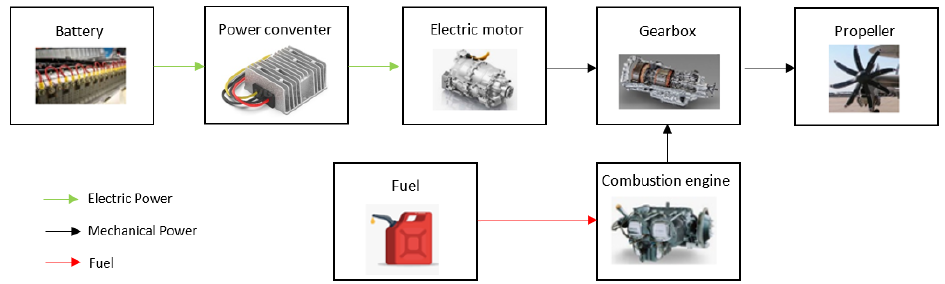
Figure 1. Parallel hybrid architecture. Source: Processed by authors.